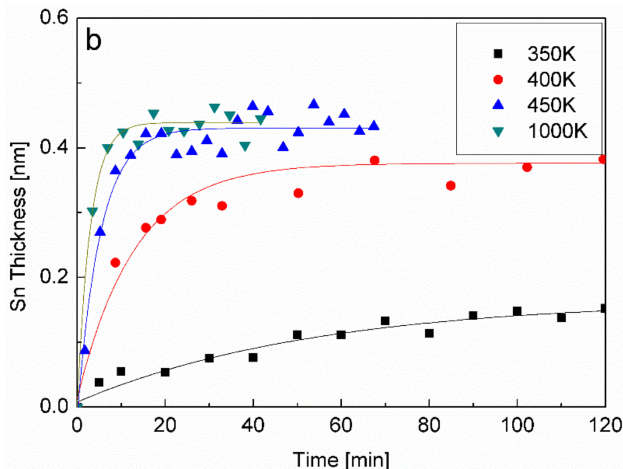
Figure 3. ( a ) Representative AES spectra of the alloy before and after heating the sample to 1000 K, indicating an attenuation of the Ti and Ni signals and an increase of the Sn; ( b ) Time depended Sn layer thickness (the lines are guide to the